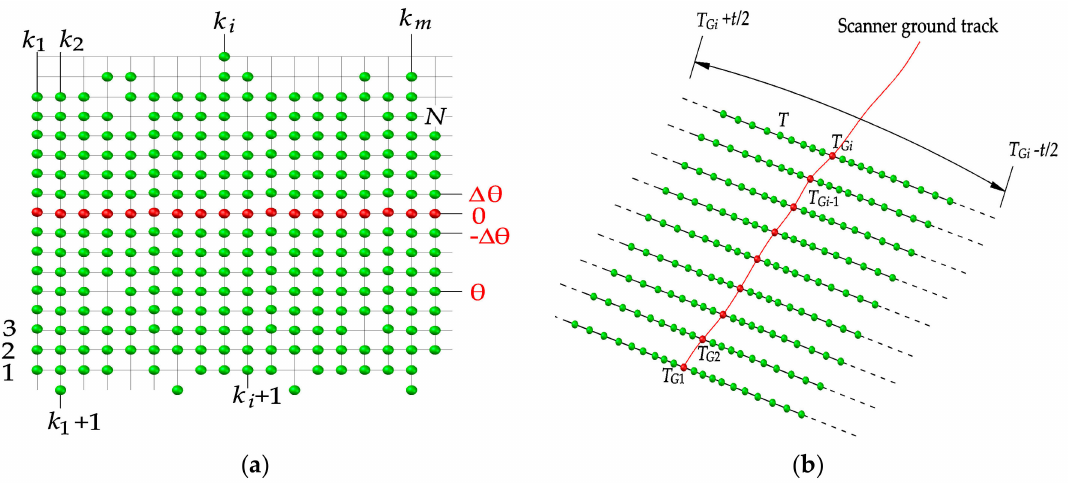
Figure 4. Construction of a Tgrid for MLS data through ( a ) the scan angle ( θ ), and ( b ) the acquisition time ( T